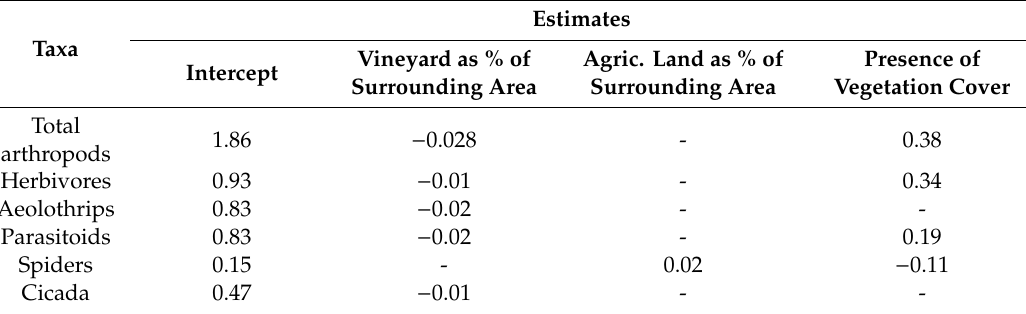
Table 4. Parameter estimates for the selected best models of the abundance of individual arthropod taxa and groups. Semi-natural elements and orchards were not among the selected models and are therefore not shown.